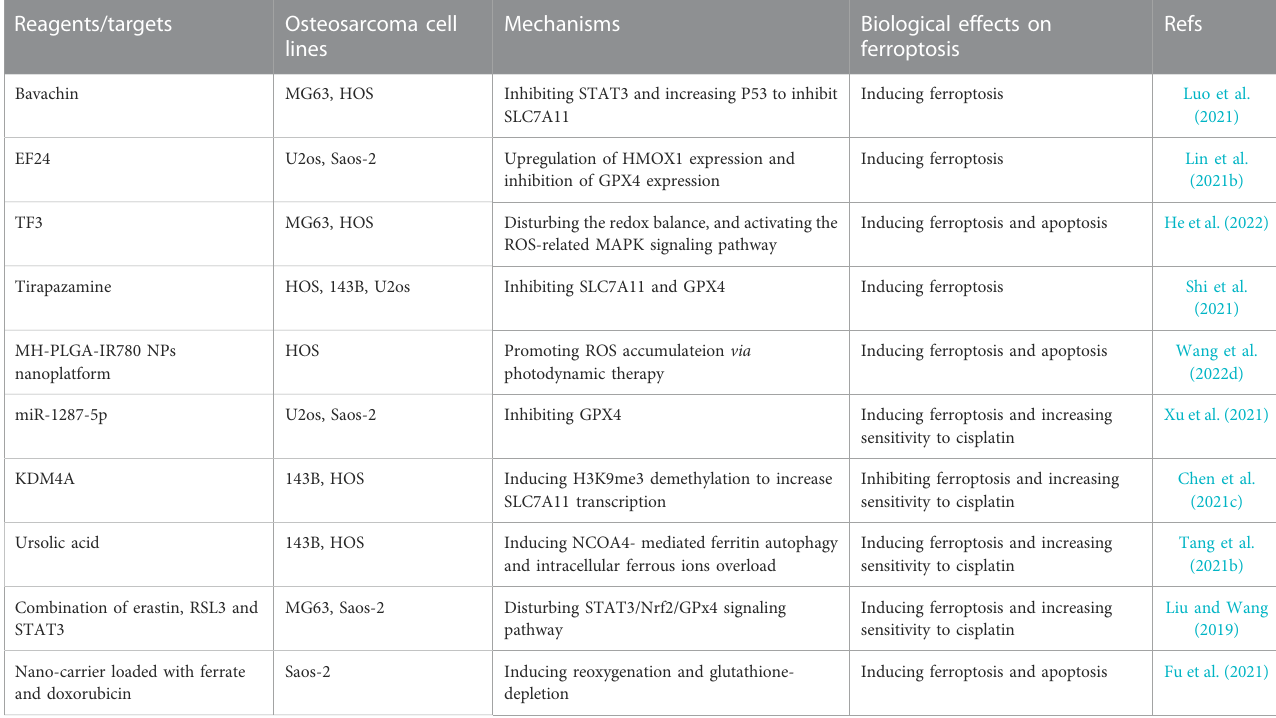
TABLE 2 Interventions and reagents targeting ferroptosis for